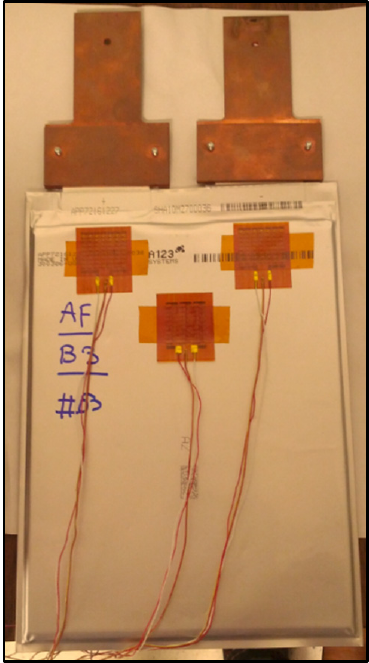
Figure 2. Heat flux sensor locations. Table 1. Specifications of battery used for testing and modeling.